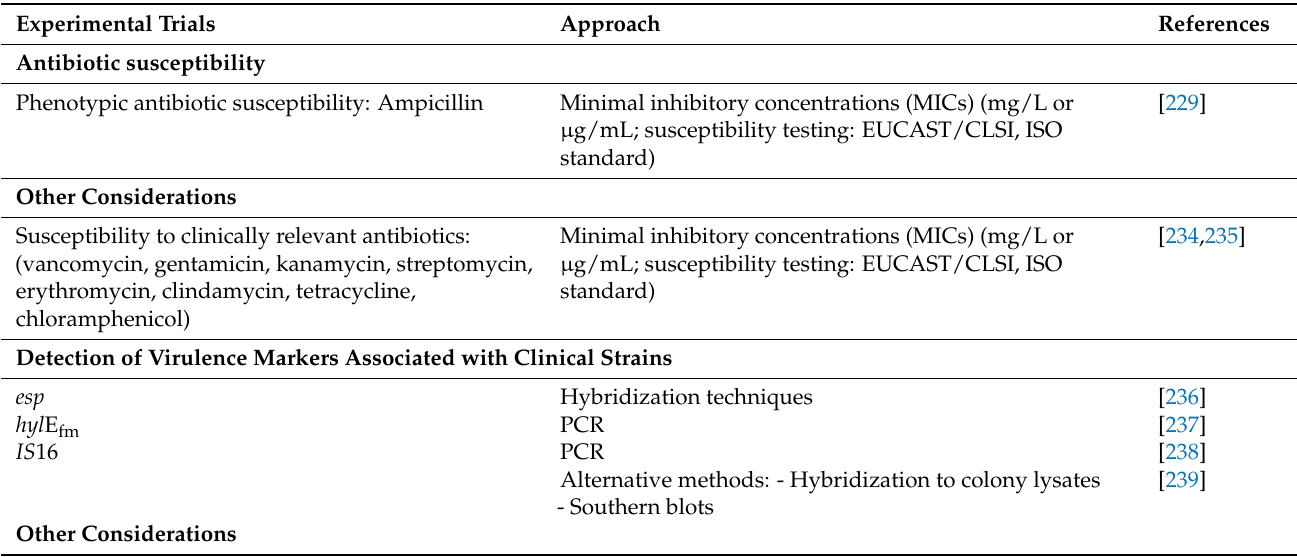
Table 4. Recommended methods for the safety appraisal of Enterococcus (non-QPS species) (adapted from [25]) with slight